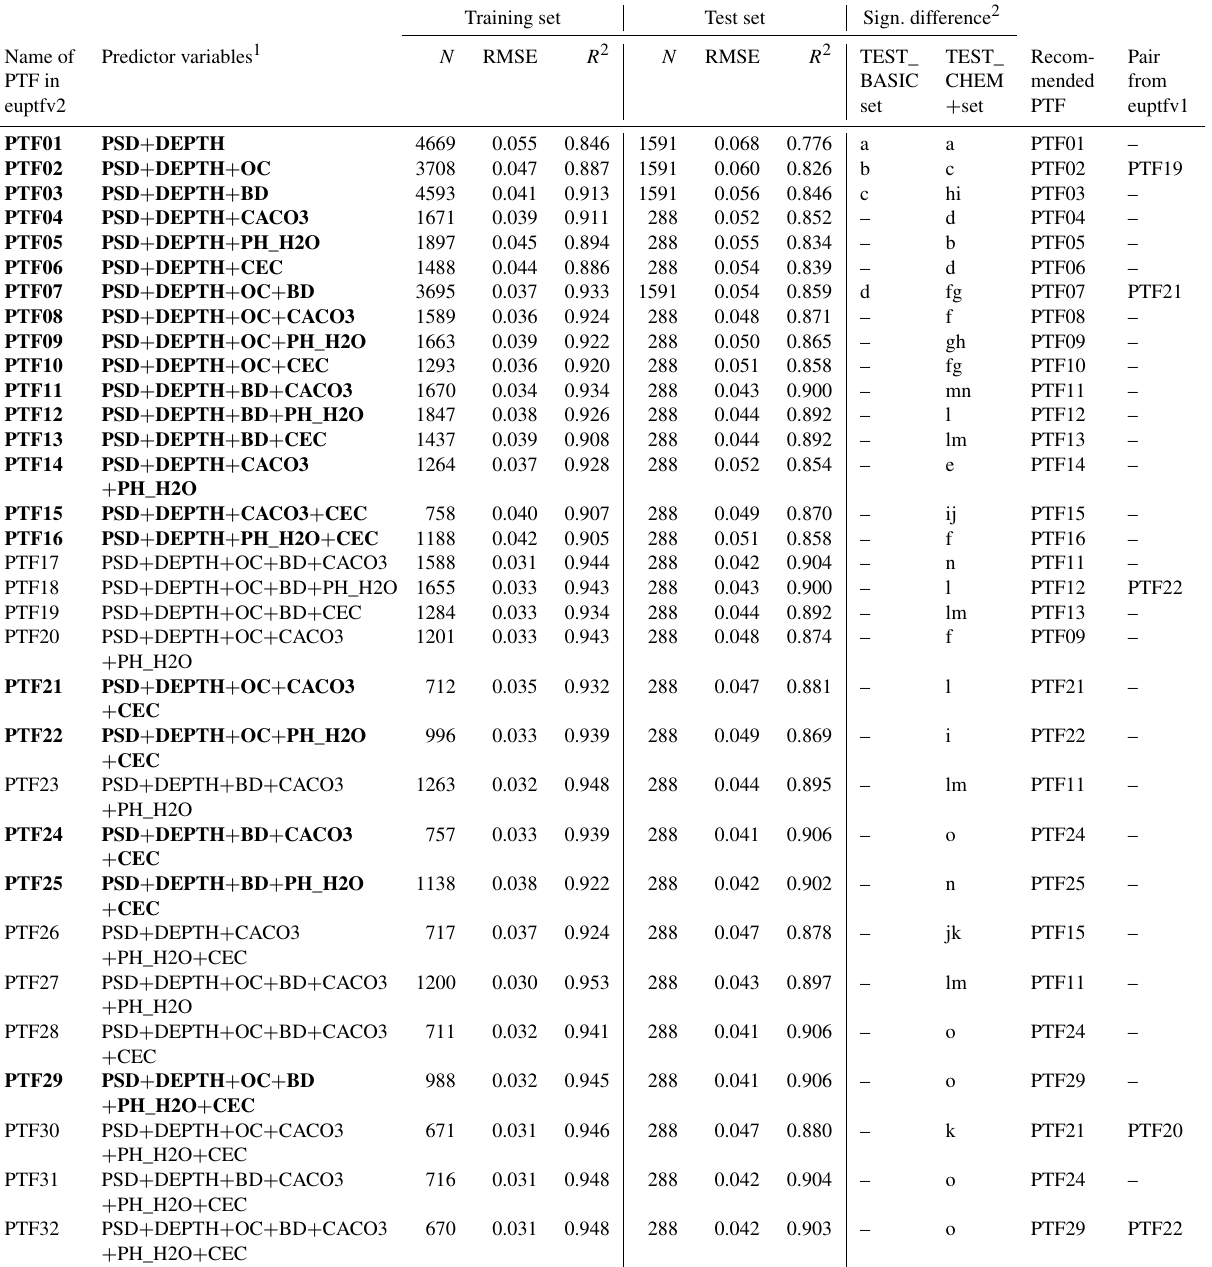
Table 7. Performance of pedotransfer functions (PTFs) by input combination on training and test datasets to predict parameters of the van Genuchten model to describe soil moisture retention curve (VG). N : number of samples, RMSE: root mean square error (cm 3 cm − 3 ), and R 2 : determination coefficient, TEST_BASIC: samples with measured PSD, DEPTH, OC and BD; TEST_CHEM + : samples with measured PSD, DEPTH, OC, BD, CACO3, PH_H2O and CEC. Recommended PTFs are highlighted in